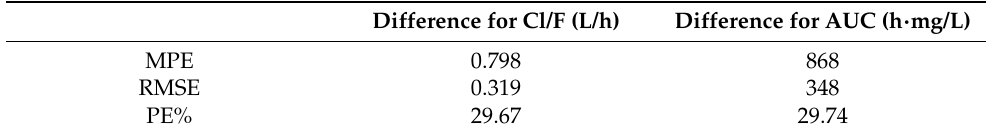
Table 3. Variation between the estimated AUC and Cl vs. real AUC and Cl.